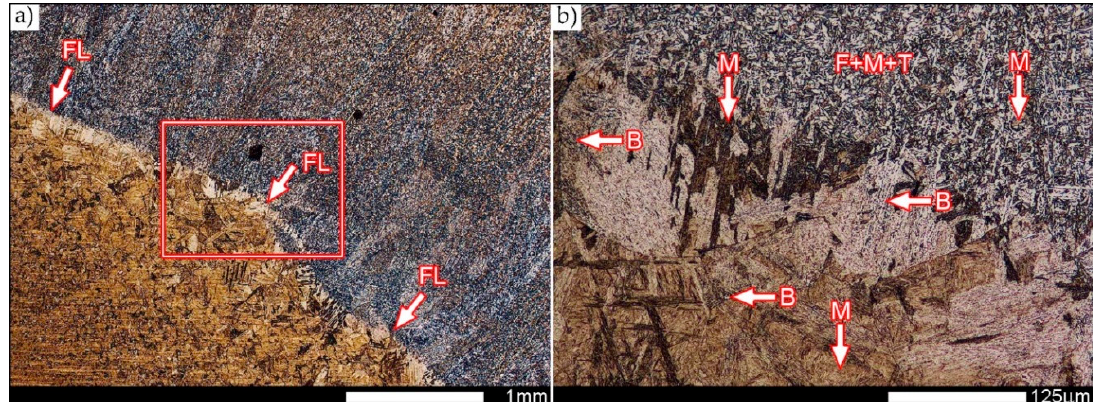
Figure 17. Microstructure of Hardox Extreme welded joint after welding: ( a ) in the area marked FZ2 in Figure 5; ( b ) an enlarged image marked with frame in Figure 17a. Very clearly outlined fusion line (FL) with strongly diversified microstructure. Visible islands of hardening martensite (M) and bainite (B), small number of troostite colonies (T) and acicular ferrite (F). Light microscopy, etched with 2% HNO 3 .